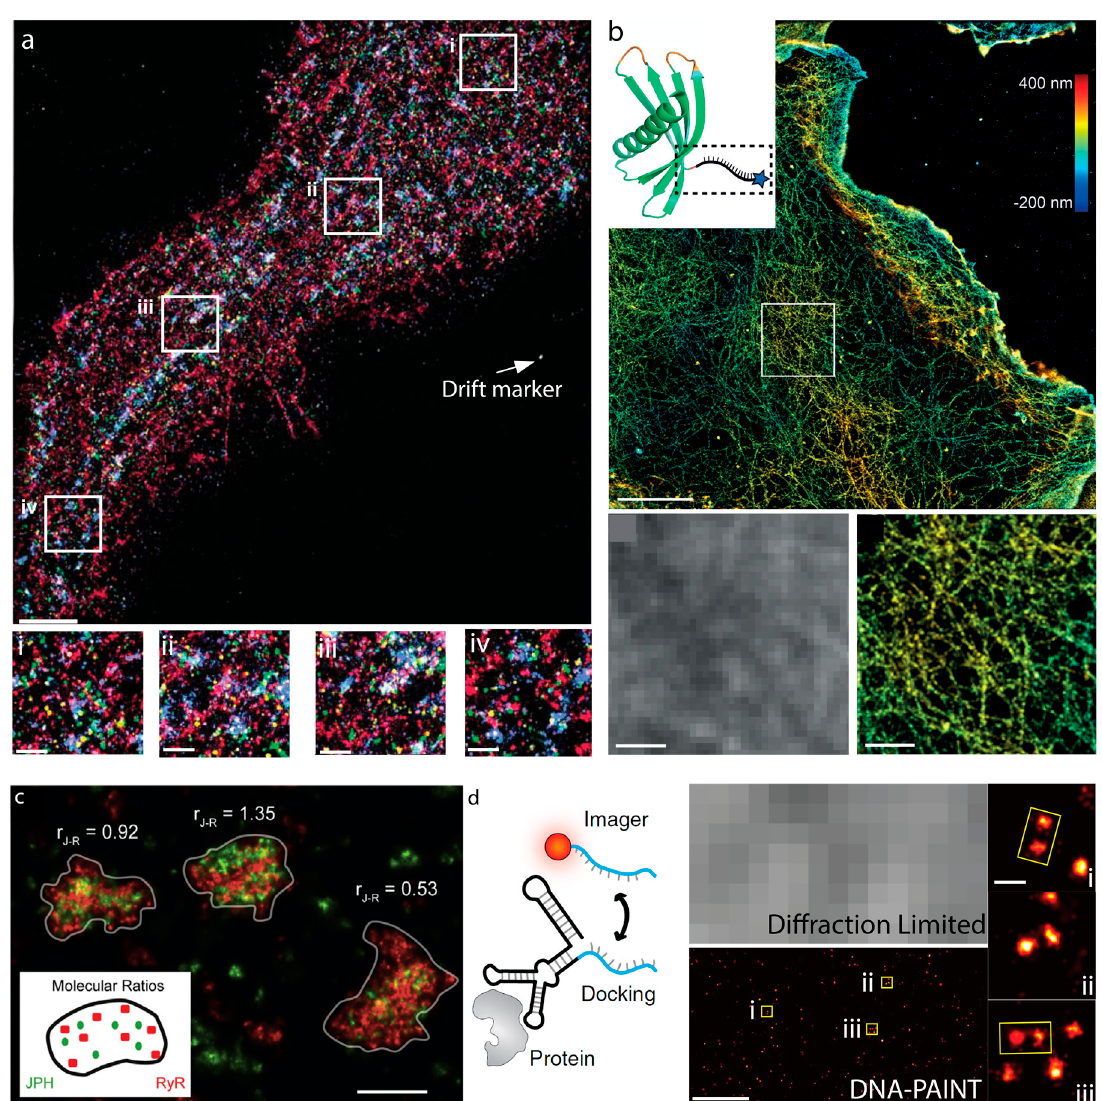
Figure 5. Cellular Imaging using DNA-PAINT. ( a ) Multiplexed Exchange-PAINT of EGFR (red), ErbB2 (green), ErbB3 (blue), IGF-1R (yellow) and Met (purple) in fixed BT-20 cells (top, scale bar-5 µm). Zoomed regions ( i – iv ) for different areas of the plasma membrane with the different protein imaged merged (scale bar = 1 µ m). Images are from [48]. ( b ) 3D DNA-PAINT of the actin cytoskeleton using labeling with affimer probes (top; scale bar = 5 µ m), inset—schematic of ribbon-structure of affimer probe with DNA docking strand attached. Comparison of diffraction limited image (left) from boxed region to 3D DNA-PAINT image (right). Scale bar = 1 µ m. Images are from [60]. ( c ) qPAINT imaging of RyR (red) and junctophilin-1 (green) clusters. Numbers indicate ratios of junctophilin-1 to RyR (scale bar—250 nm). Images are from [47]. ( d ) SOMAmers for DNA-PAINT imaging of single proteins on fixed and live cells. Schematic of SOMAmers labeling and application to EGFRs in the plasma membrane (left). Comparison of diffraction limited image (top, middle) to the DNA-PAINT final convolved image (bottom, middle). Scale bar = 200 nm. EGFR dimers observed in the DNA-PAINT image, regions ( i – iii ) corresponding to identified dimers (scale bar = 20 nm). Images are from [61].